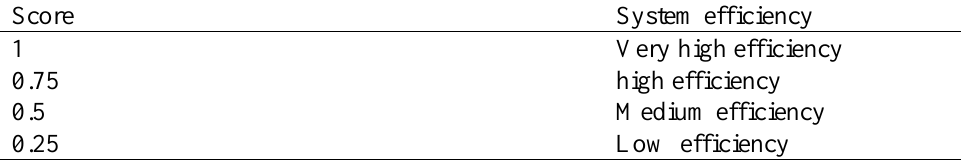
Table 8. Proposed scores for quantification of system efficiency by RAM-D method